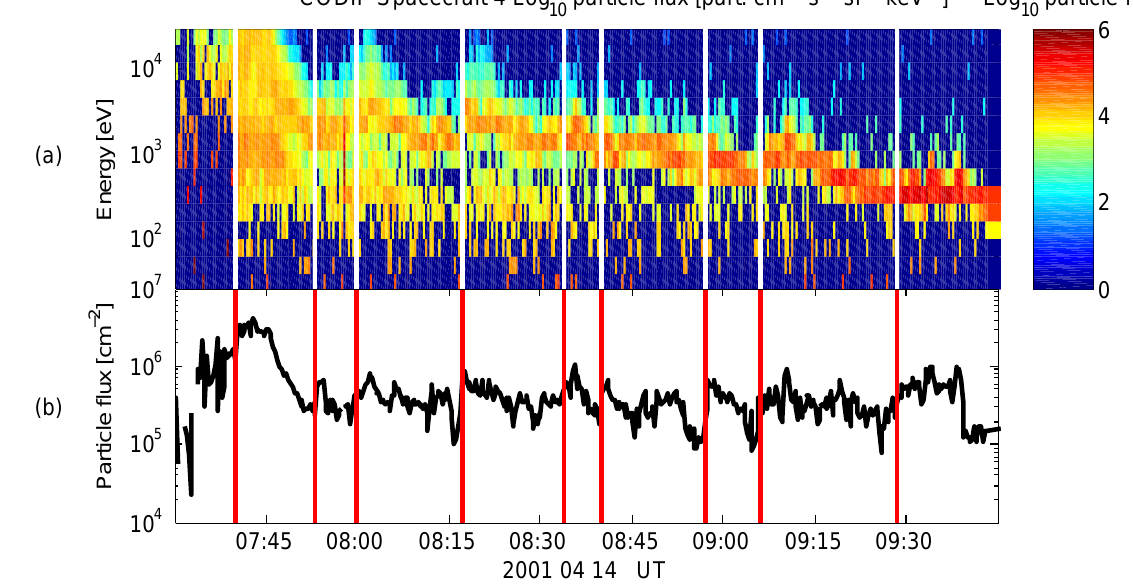
Fig. 1. Oxygen ion data from Cluster spacecraft 4, taken on 14 April 2001. (a) Omnidirectional differential particle flux of O + [cm − 2 s − 1 sr − 1 keV − 1 ]. Automatically detected number flux enhancement events are indicated with vertical white lines. (b) Line plot of the O + field aligned number flux [cm − 2 ], calculated as the integrated total flux for particles above 40eV. All flux is outward, i.e. away from Earth.. Automatically detected number flux events are indicated with vertical red